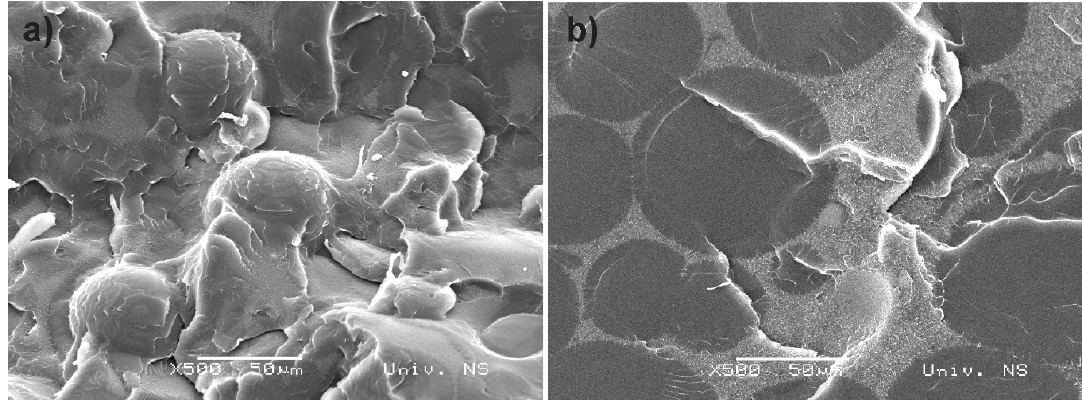
Figure 3. Fracture surfaces obtained after flexural testing of specimen 0 ( a ) and specimen modified with 2% nanosilica. A different crack propagation mode is revealed: predominantly through the nanocomposite between pre-polymerized powder particles ( a ) and through both pre-polymerized powder particles and polymerized nanosilica reinforced composite material ( b ).